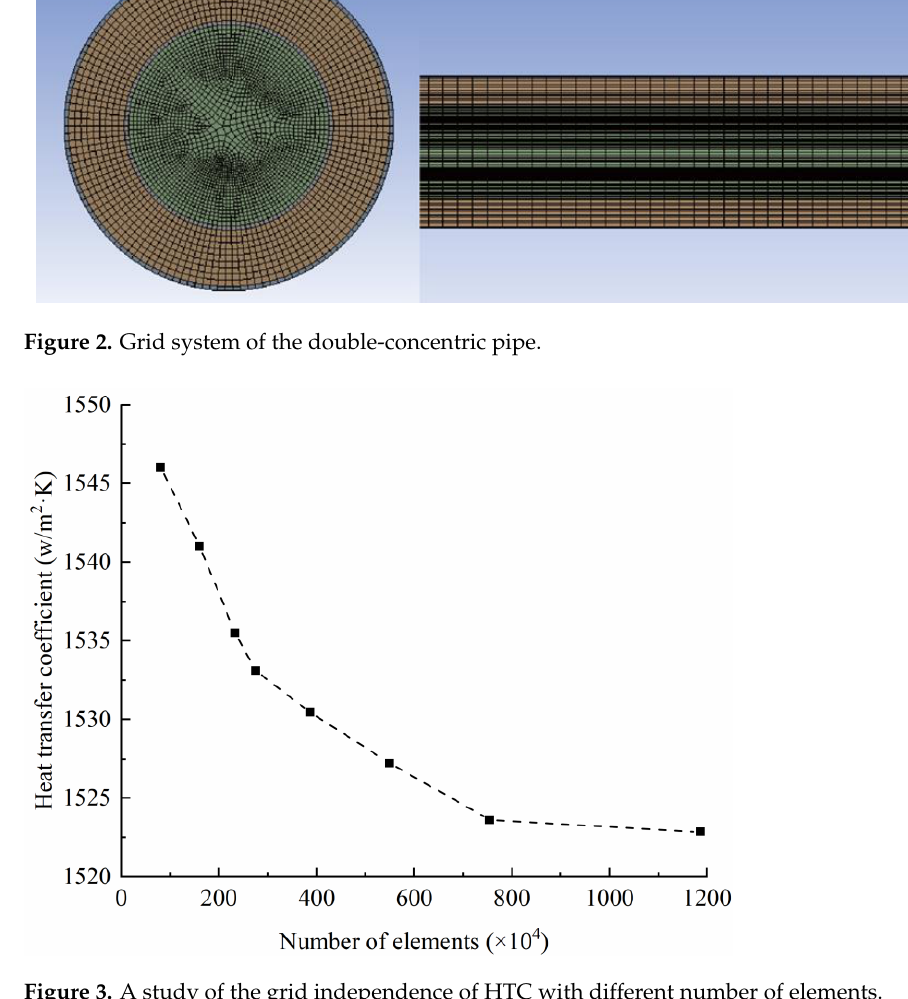
Figure 3. A study of the grid independence of HTC with different number of